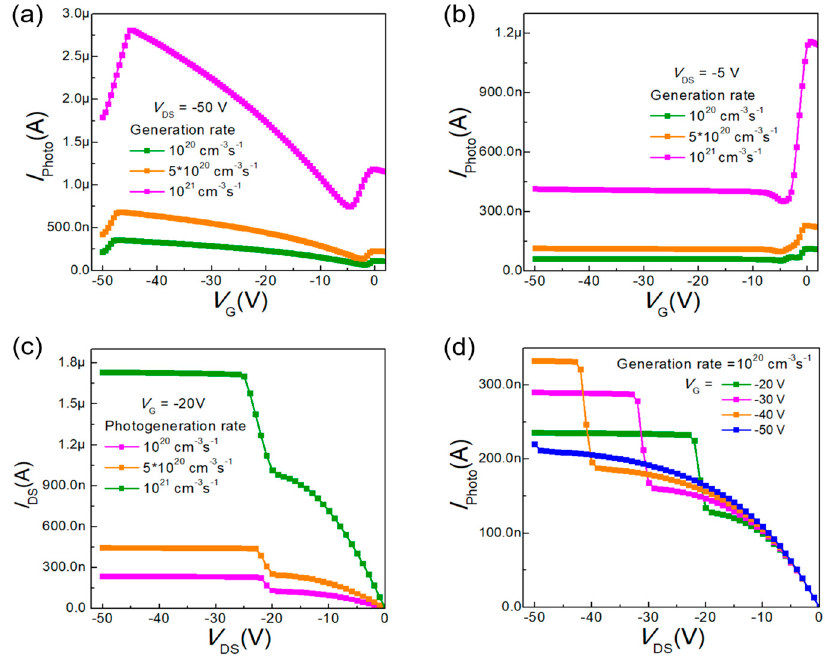
Figure 4. Photocurrent as a function of gate bias ( a , b ) and drain bias ( c , d ) at different photogenera- tion rates.